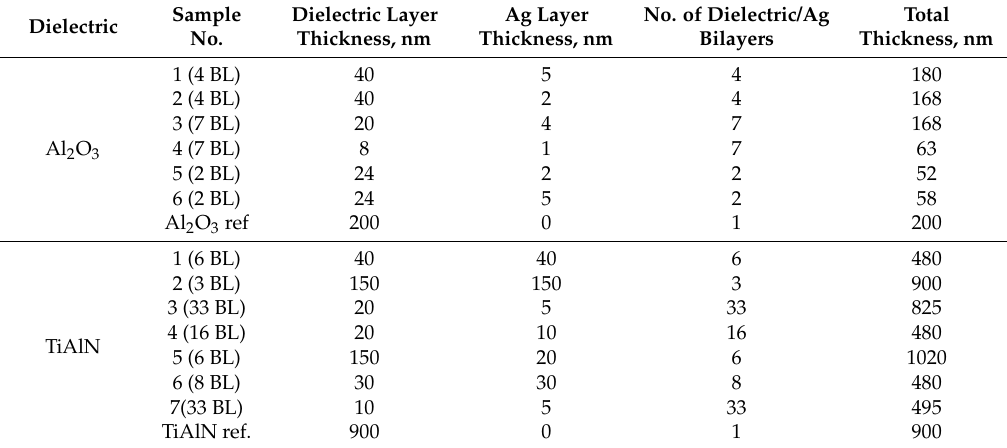
Table 1. Composition parameters of multilayer